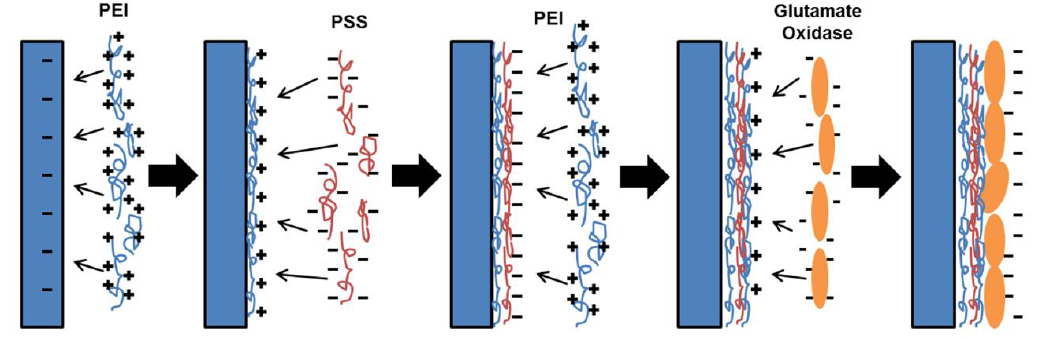
Figure 3. Layer-by-layer assembly of glutamate oxidase (GLOD) on a substrate. Electrostatic adsorption and charge resaturation occurs on the substrate to form alternate layers of polyelectrolyte and GLOD